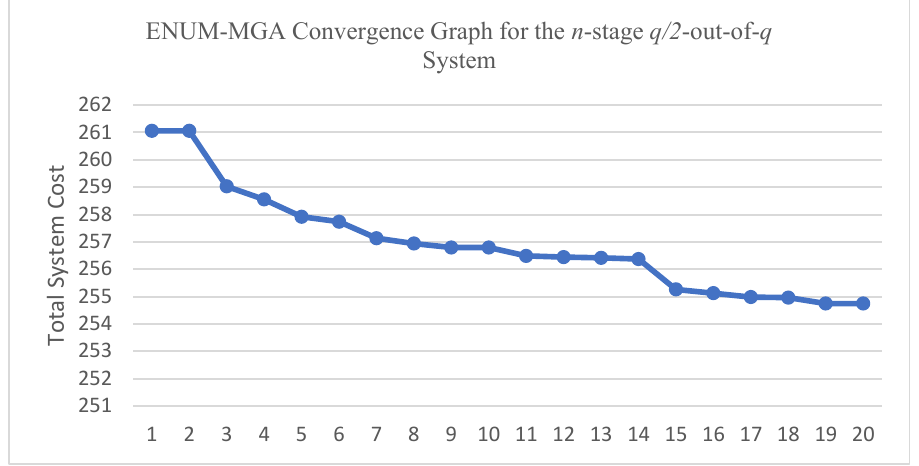
Figure 13. The convergence graph of the n -stage q /2-out-of- q system by applying the ENUM-MGA combined method.